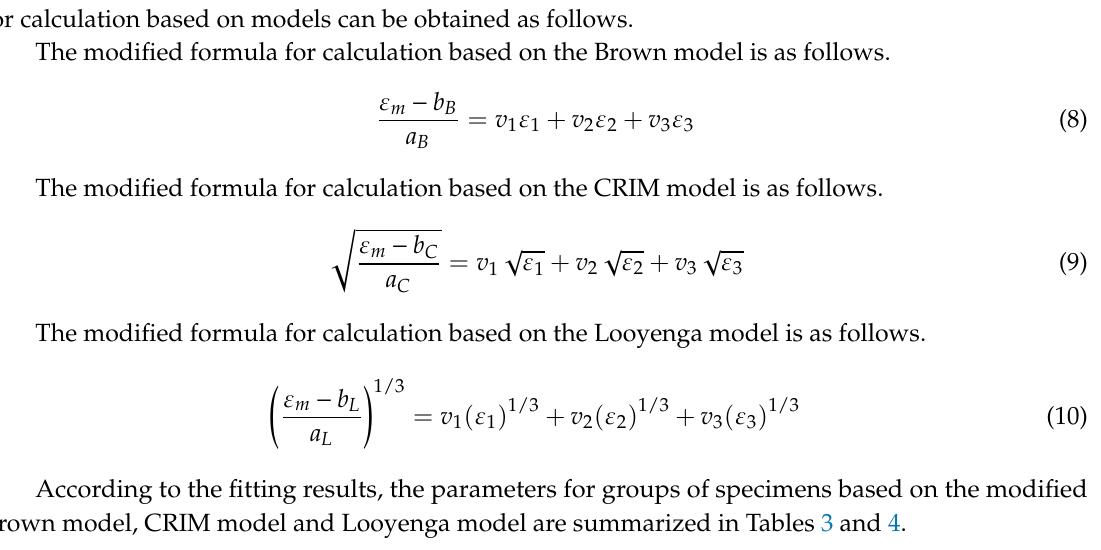
Table 3. Parameter ε , based on modified models.